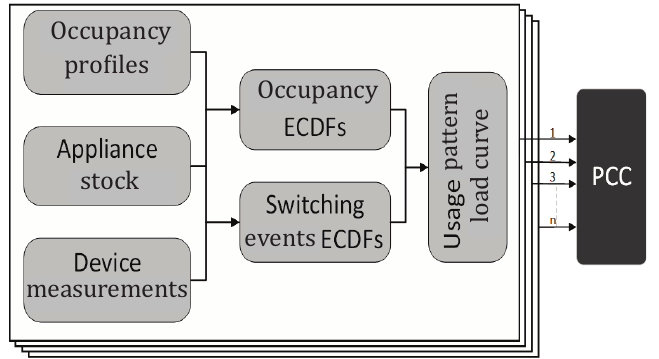
Fig. 5. Abstract diagram of the appliance usage